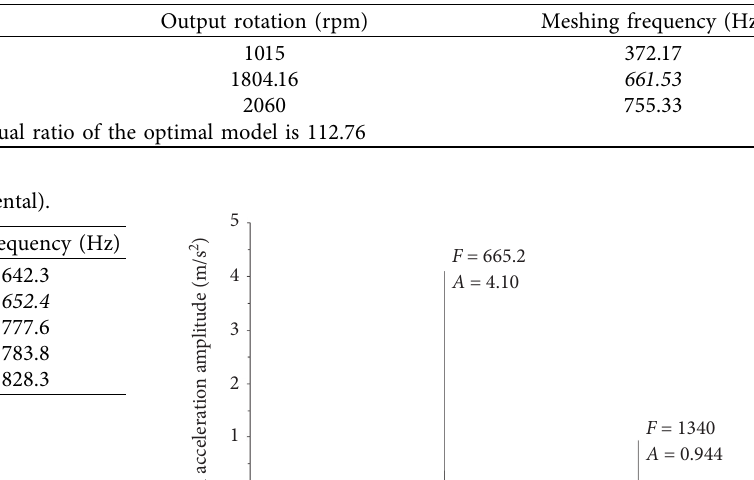
Table 11: Gear mesh frequencies of optimal parallel-axis helix stage.